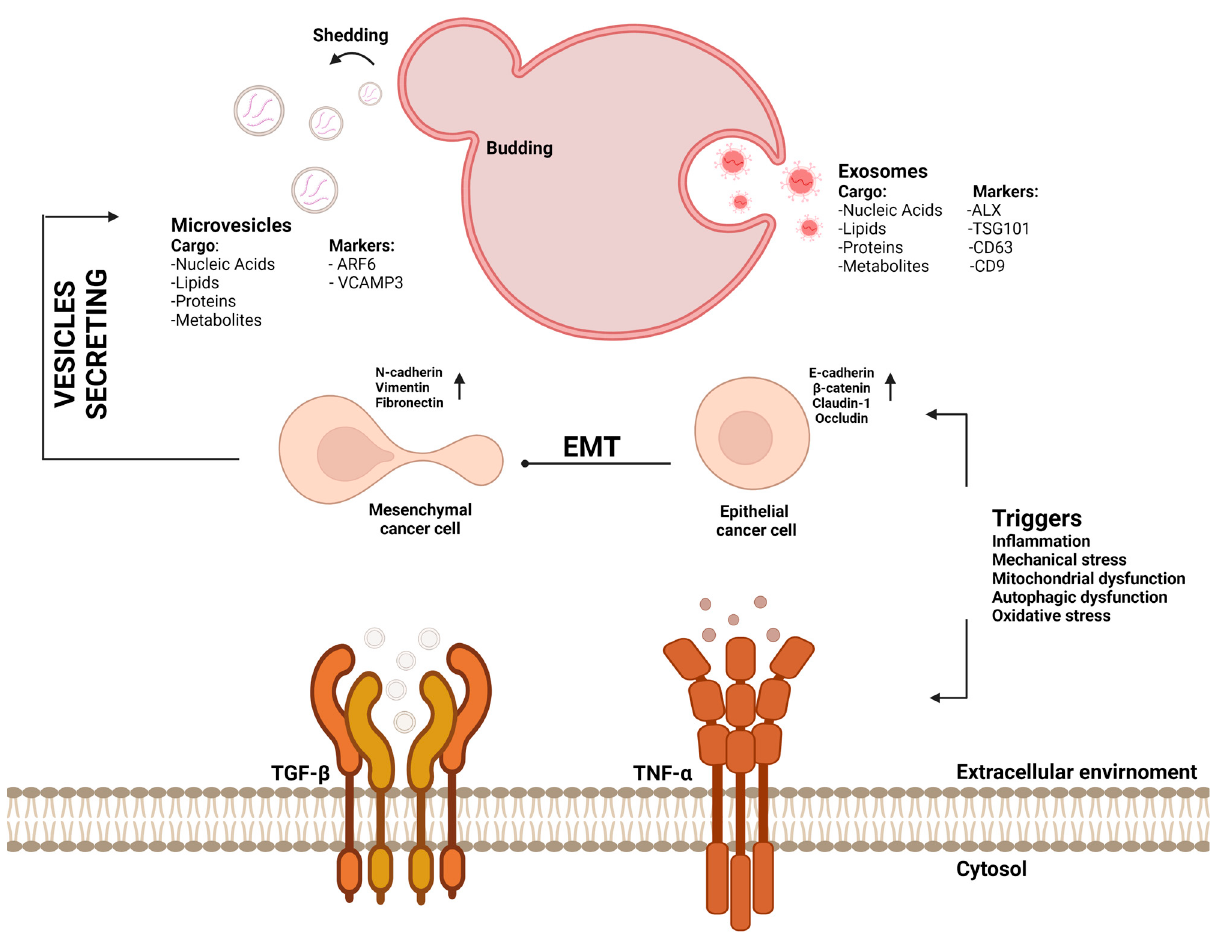
Figure 2. The mechanism of EV secretion induced by TGF- β activation. This figure describes the impact of extracellular vesicles relative to TGF- β signaling by focusing on mechanisms by which EV cargo can influence cancer formation, metastasis progression, immune evasion, and response to anticancer treatment by EMT mechanisms. The duality of interactions between TGF- β and TNF- α and the expression of these inflammatory factors induce the EMT mechanism, which is associated with EV secretion. These membrane-based populations are important communicators between tumor cells and their microenvironment. Various pathological conditions can favor the activity of TNF- α and TGF- β , among which we can distinguish mainly inflammation, mechanical stress, mitochondrial dysfunction, and oxidative stress. Exosomes or microbubbles are only selected as follicle populations in response to the described factors. During the induction of inflammation associated with increased cell migration and change in their shape, migrasomes, a population of extracellular vesicles detached from the retraction fibers of the cell during the migration process and then absorbed by neighboring cells or circulating in the extracellular matrix, may be